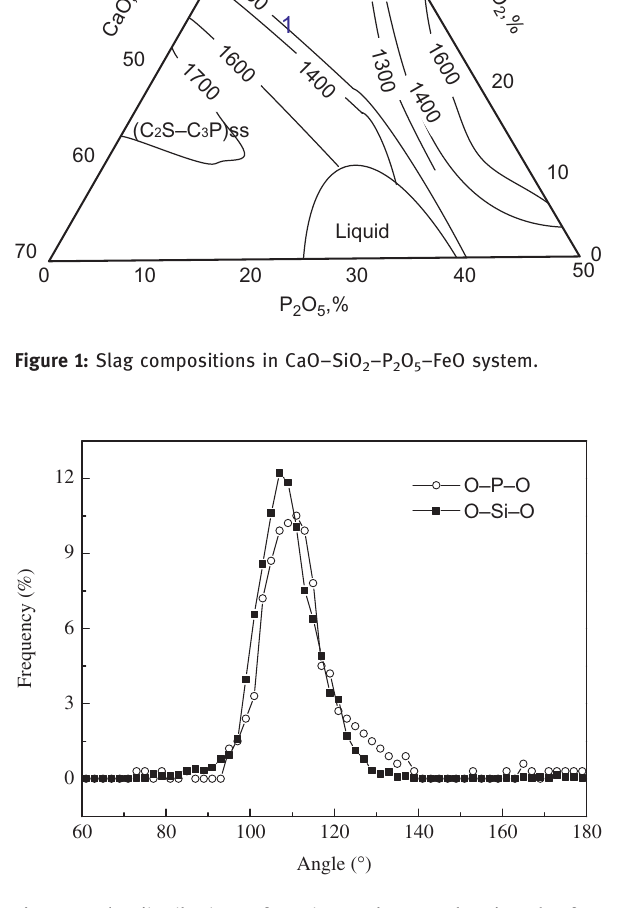
Figure 2: The distributions of O – Si – O and O – P – O bond angles for No. 2 slag.